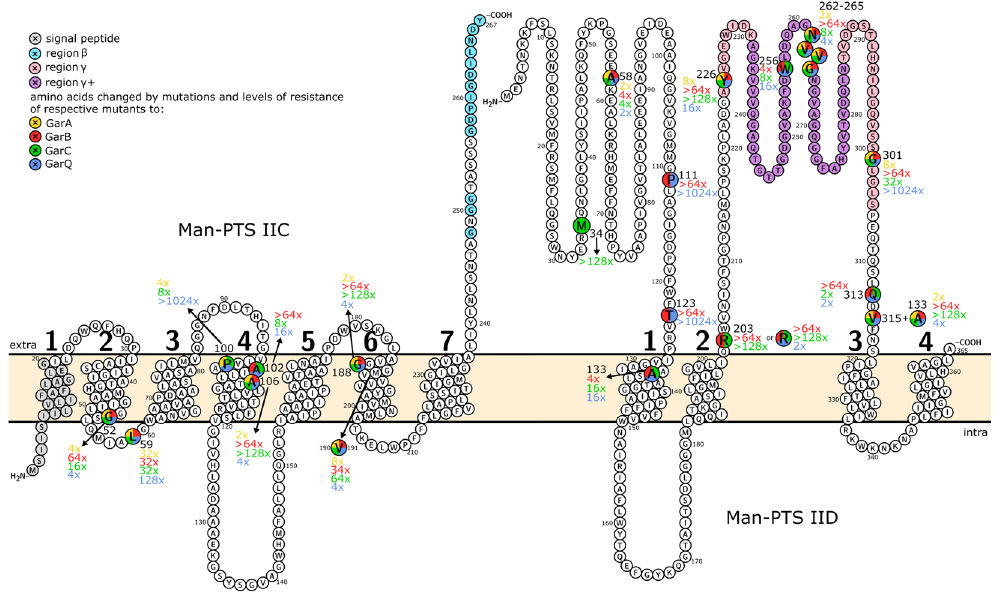
Figure 5. Predicted topology of L . garvieae IBB3403 Man-PTS subunits IIC and